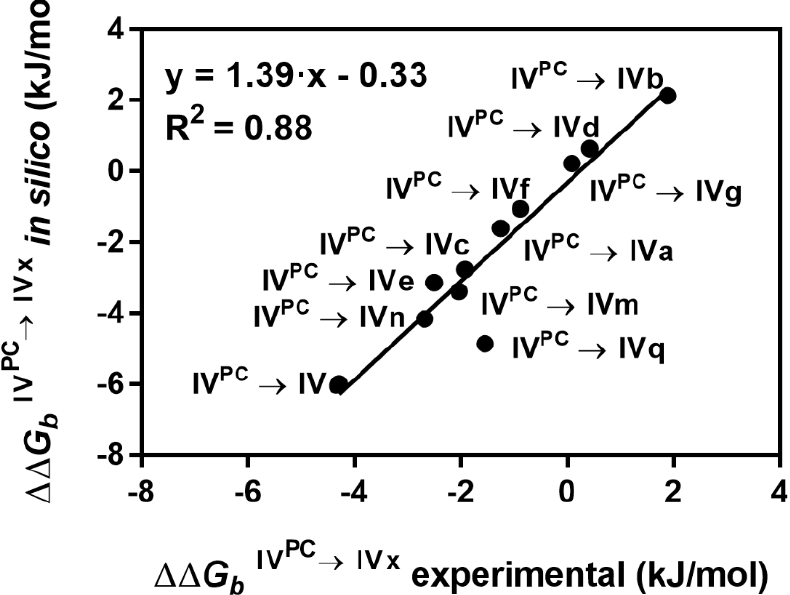
Figure 4. Correlation between computational (by AFEC) and experimental (by ITC) relative binding free energies for the binding of IV PC and the IVx analogues to the enzyme PAH. The AFEC data were obtained by simulating the PAH enzyme as coordinating an FeII iron ion. The straight line corresponds to a linear fit. The fitting equation and the square Pearson coefficient of the fit are also depicted.